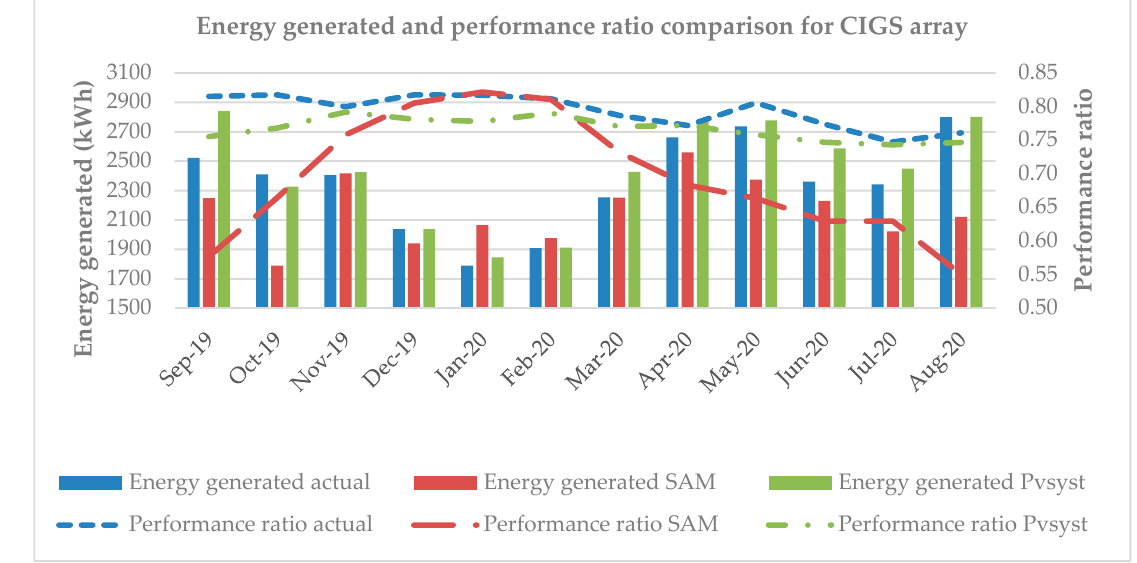
Figure 16. Comparison of actual energy generated and performance ratio to simulated values for monocrystalline silicon array.